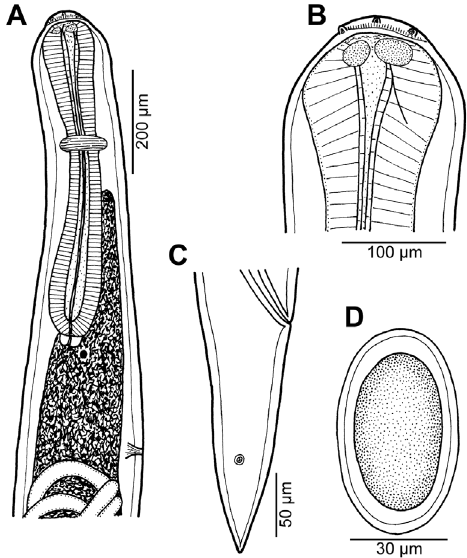
Figure 16. Dichelyne ( Cucullanellus ) branchiostegi (Yamaguti, 1941) from Branchiostegus wardi , gravid female. (A) Anterior end of body, lateral view; (B) cephalic end, lateral view; (C) tail, lateral view; (D)